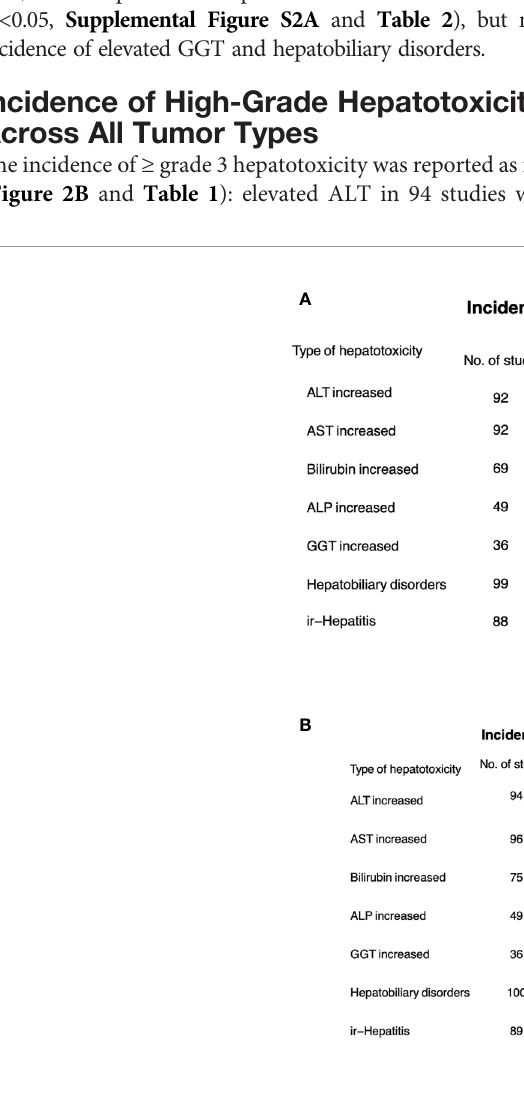
Ir-hepatitis: immune related